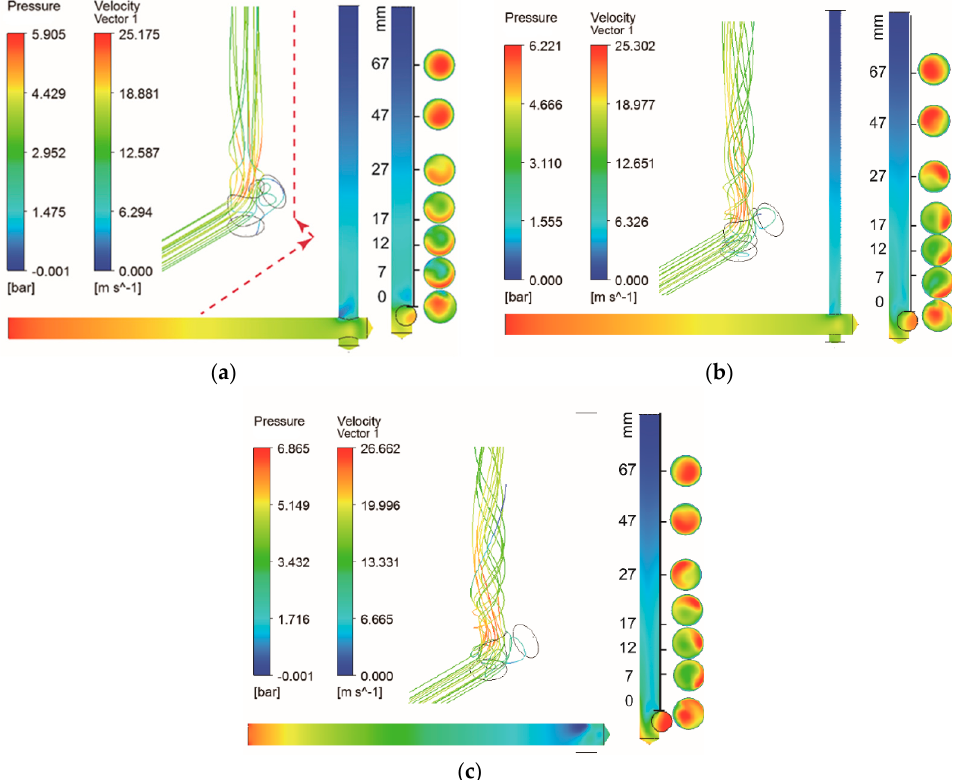
Figure 12. Pressure and velocity distribution: ( a ) III ‐ 0.2, ( b ) III ‐ 0.4, and ( c ) III ‐ 0.6.